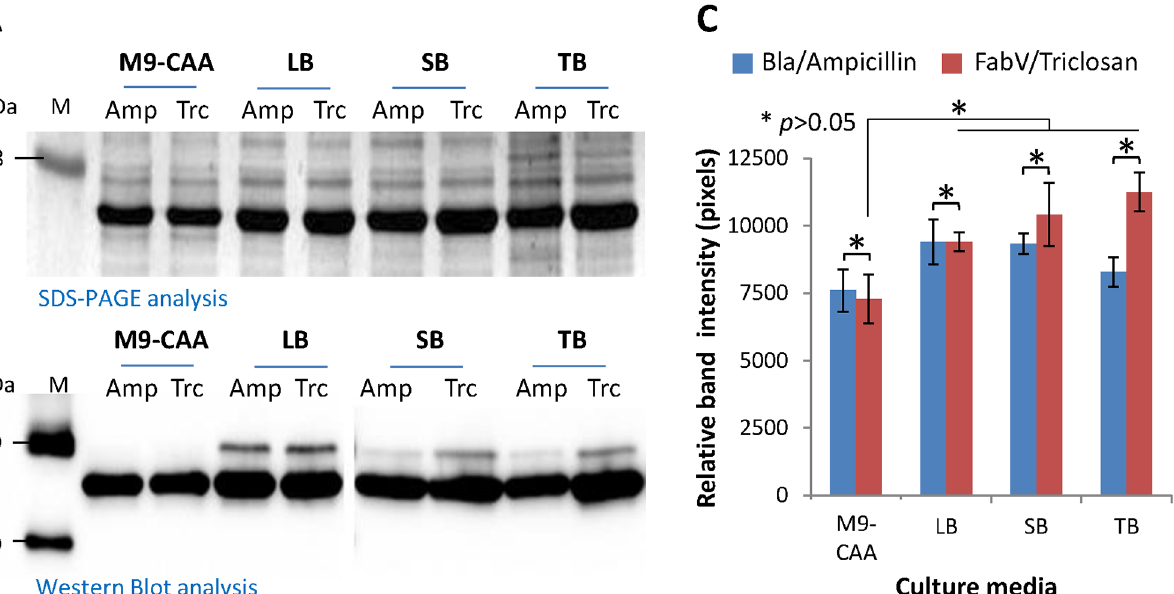
Fig 2. FabV-Triclosan selection system is compatible with culture media commonly used for recombinant protein expression. BL21(DE3) cells were transformed with pSA-HP24-Bla or pSA-HP24-FabV plasmids and cultured in different culture broths supplemented with either 269 μ M (100 μ g mL -1 ) Ampicillin or 1 μ M Triclosan respectively. Protein expression was induced with 50 μ M IPTG when cultures reached to 0.5 OD600. Induced and uninduced cultures were grown at 30°C for 6 hours and then analyzed by SDS-PAGE (A), Western blot (B), and densitometry (C) for the expression of recombinant P24 protein. Error bars show standard deviations calculated from at-least three independent experiments each performed in